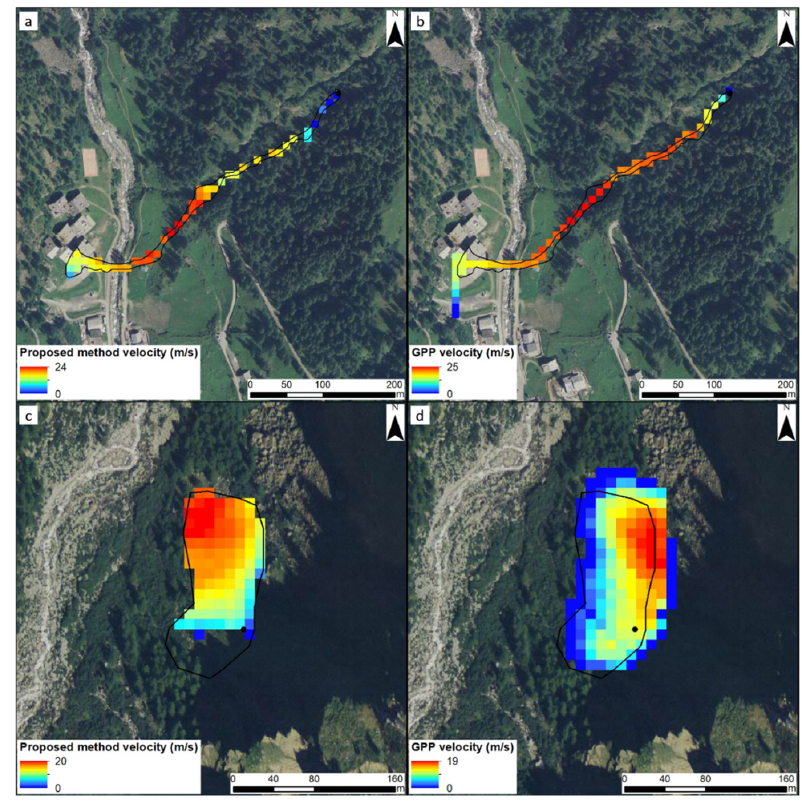
Figure 9. Other examples of the application of the proposed method and GPP model. ( a ) Velocity values of a shallow landslide obtained by a Matlab code based on the Heim method; ( b ) velocity values of the same shallow landslide shown in ( a ) obtained by the GPP model; ( c ) velocity values of a rockfall obtained by a Matlab code based on Heim method; ( d ) velocity values of the same rockfall shown in ( c ) obtained by the GPP model. In all the figures, the continuous black line corresponds to the landslide boundary, and the black point to the release reference point according to the IFFI